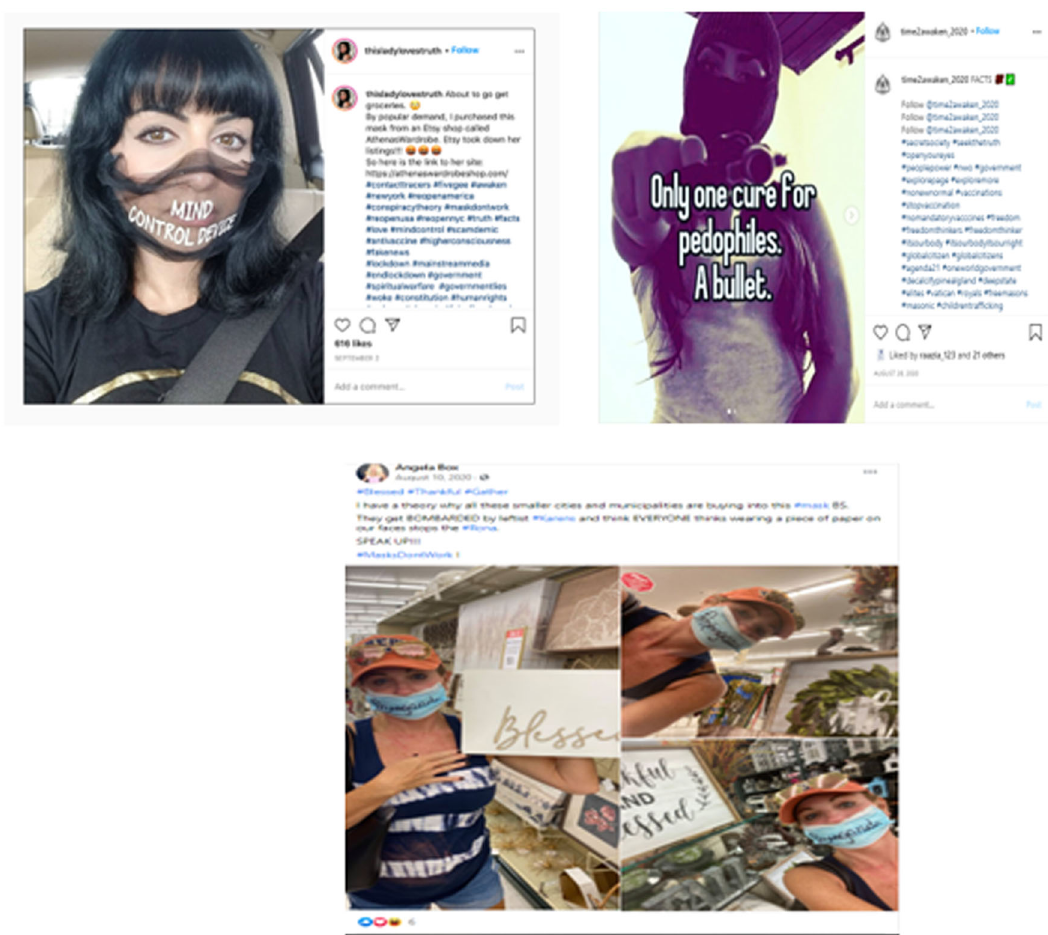
Fig. 4 Social media posts representing the third discourse on appropriating freedom and feminism.